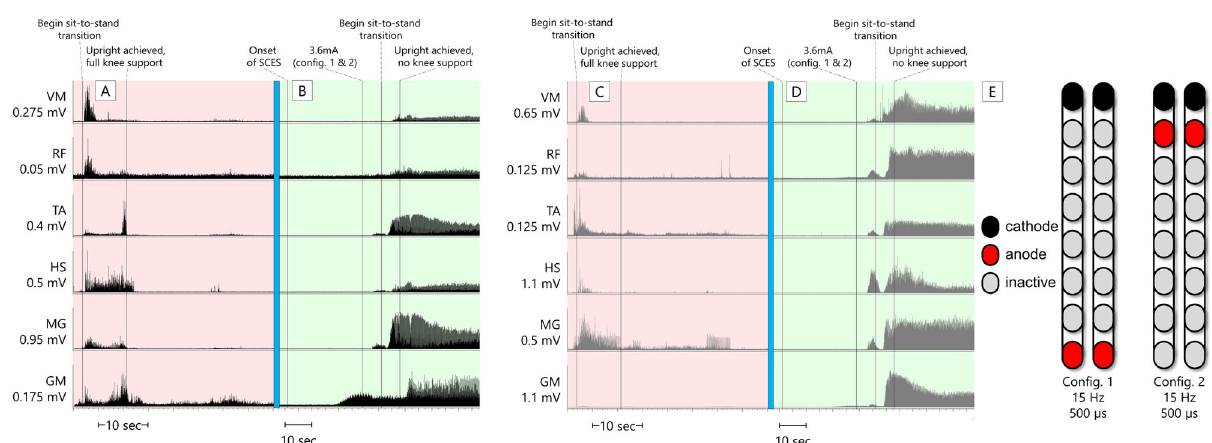
Fig. 6 | 0773 overground standing. Electromyograms (EMGs) of lower extremity musclesof0773duringovergroundstandinginparallelbars. A , C left(blacktraces) and right (gray traces) leg muscles, respectively, during upright, overground standing with SCES off. 0773 was able to use his upper extremities to self-assist himself into an upright position with the knees blocked by a study team member, and once upright, required full support at the knees to maintain the upright posi- tion.EMGactivityduringthesit-to-standtransitionwasabriefperiodofspasticity – onceupright, muscle activitylargely ceased. B , D left (blacktraces) and right (gray traces) leg muscles, respectively, during upright, overground standing with SCES on using con fi gurations shown in E . From the onset of SCES, the amplitude was